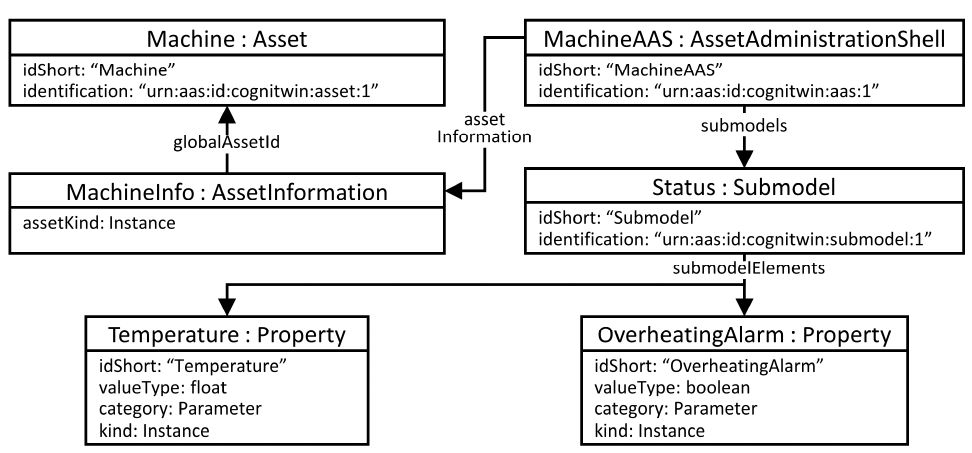
Figure 2. General architecture for realizing hybrid digital twins.